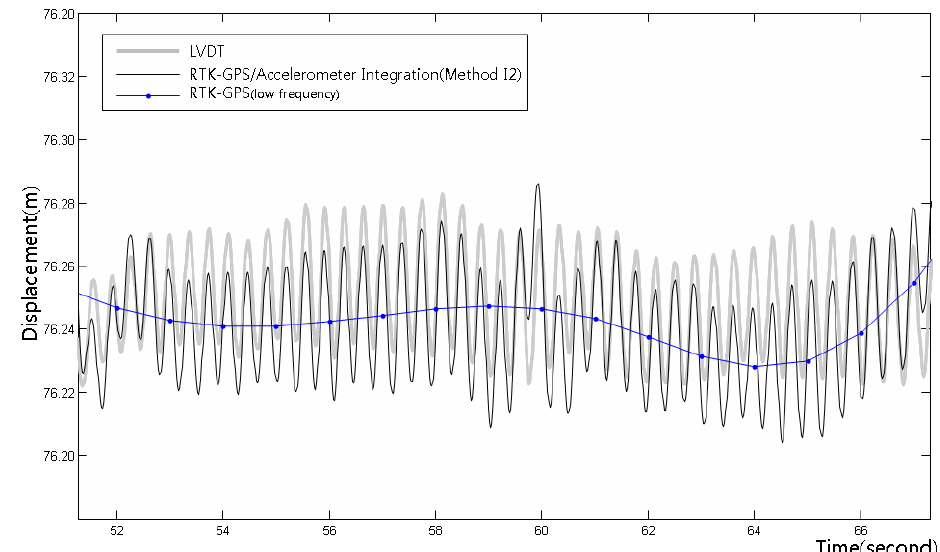
Figure 19. LVDT measurements and integrated RTK-GPS/accelerometer calculation results for the enlarged dashed rectangle area in Figure 18.